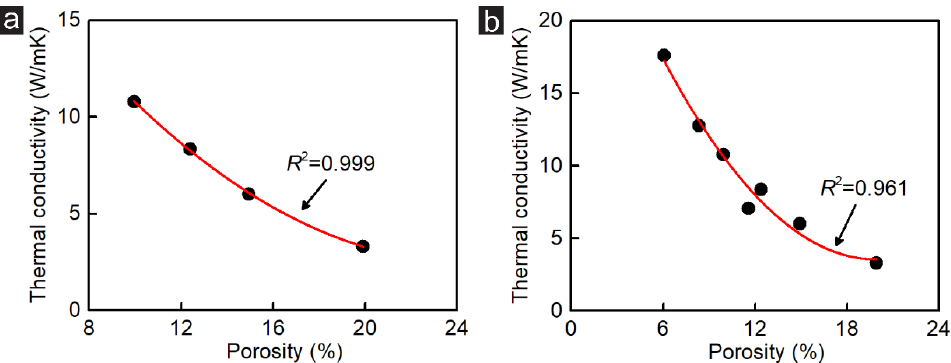
Figure 5. Relationship between the DD and the thermal conductivity on zigzag-incised GK ( a ) in Group_2 and ( b ) in both Group_1 and Group 2.